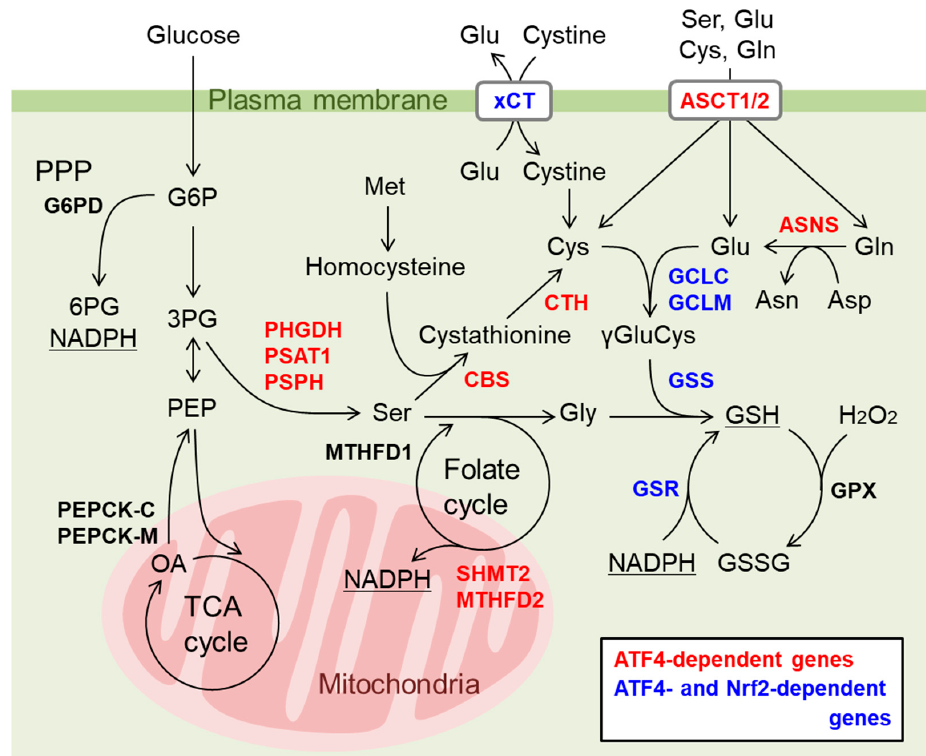
Figure 6. Cooperative regulation of genes involved in glutathione (GSH) and NADPH synthesis by Nrf2 and ATF4. Carnosic acid activates both Nrf2 and ATF4 and induces antioxidant genes and genes involved in amino acid synthesis/transport and GSH synthesis. The contributions of Nrf2 and ATF4 to the gene activation were analyzed by knockdown of Nrf2 or ATF4 and shown with color characters ( [124] and our unpublished observation). Induction of cystine transporter xCT and GSH synthetic enzymes (GCLC, GCLM, GSS, and GSR) was dependent on both Nrf2 and ATF4 (genes indicated with blue). Genes involved in serine synthesis (PHGDH, PSAT1, and PSPH), transsulfuration (CBS and CTH), folate cycle (SHMT2 and MTHFD2), and asparagine synthase (ASNS) and Ala/Ser/Cys/Thr transporter-1 and -2 (ASCT1/2) are dependent on only ATF4 and indicated with red. Colored genes are also up-regulated in HSA-UCP1-Tg mice [132] except for ASCT1 and additionally include G6PD, PEPCK-C, PEPCK-M and MTHFD1 (indicted with black). G6PD is a rate-limiting enzyme of pentose phosphate pathway (PPP) that supplies NADPH and is known as an Nrf2 target gene [28] . PEPCKs may redirect TCA cycle metabolites to Ser synthetic pathway and are reported as ATF4-regulated genes [135,136] . Folate cycle converts Ser to Gly and up-regulation of mitochondrial SHMT2 and MTHFD2 may increase mitochondrial NADPH [29] .